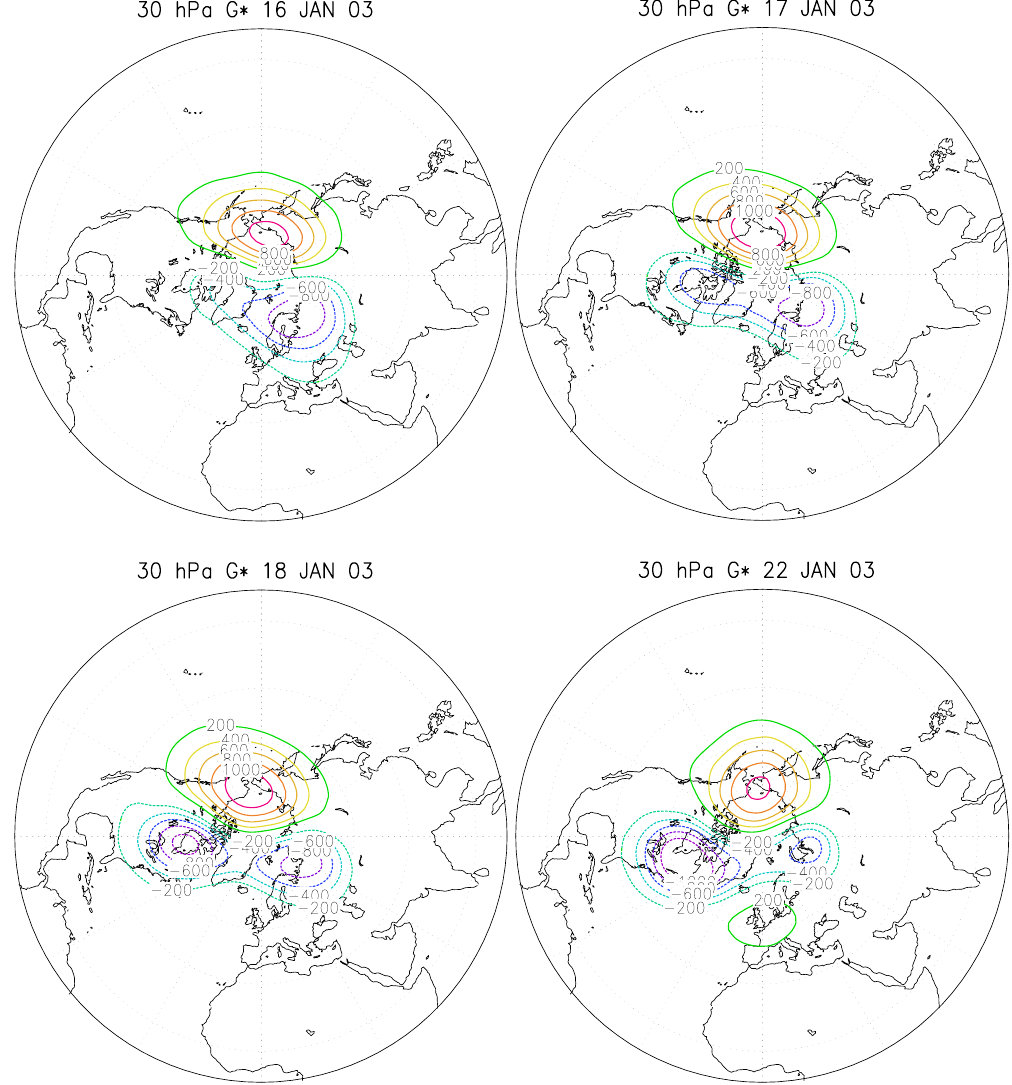
Fig. 1. Stereographic projection of geopotential height G * (dam) at 30hPa for 16, 17, 18 and 22 January 2003. G * perturbation is defined as deviation from zonal